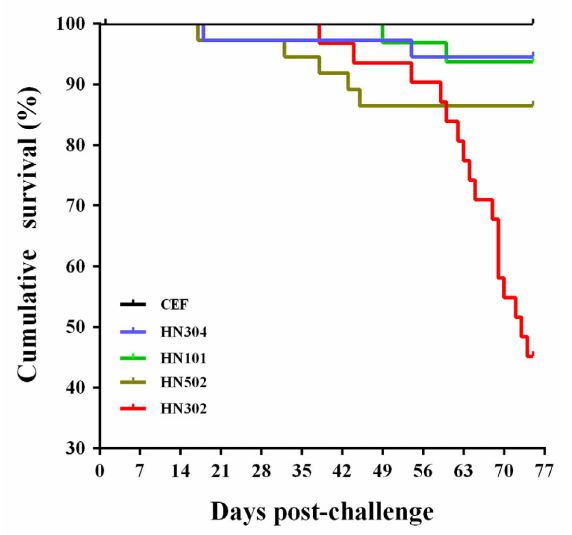
Figure 2. Survival curves of chickens challenged with distinct MDV strains over the 75-day experi- mental time period. For each experimental group, the birds were separately challenged with CEFs containing 2000 PFU viruses by intra-abdominal inoculation, while for the negative controls, a fifth group of birds were inoculated with an equal volume of mock-infected CEFs. Early deaths due to intra-abdominal infection adverse effects and birds sacrificed for body weighting and immune organ collections were excluded for data calculation.